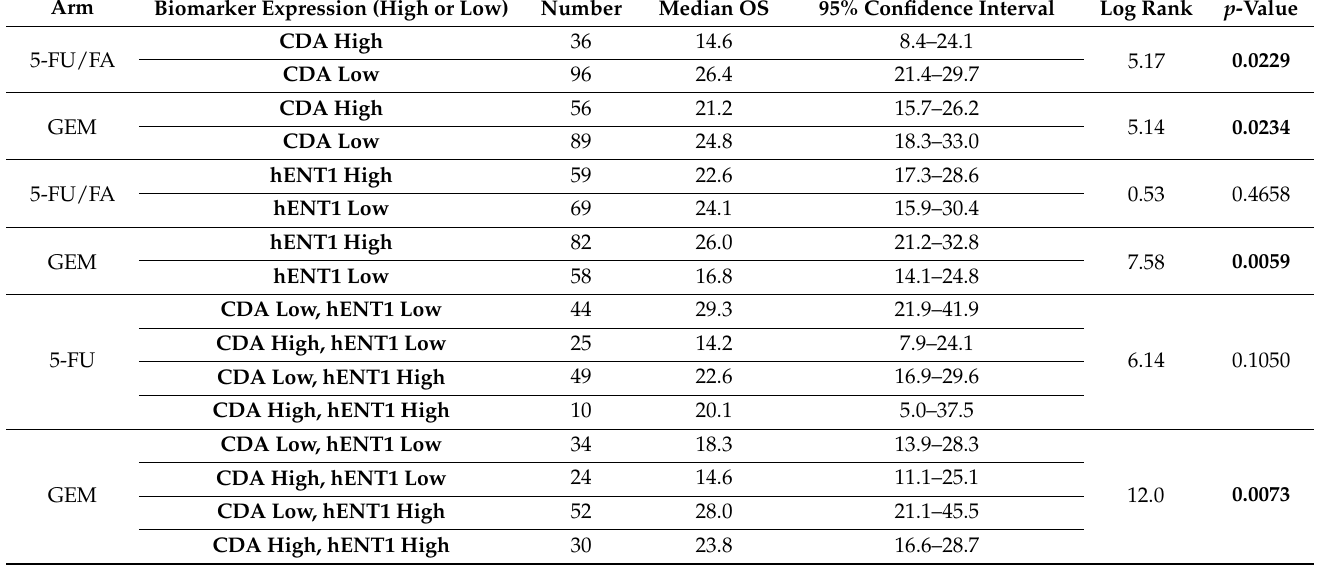
Table 3. Median overall survival in subgroups split by treatment arm, 5-FU or gemcitabine (GEM), cytidine deaminase (CDA) mRNA, and human equilibrative nucleotide transporter-1 (hENT1) protein